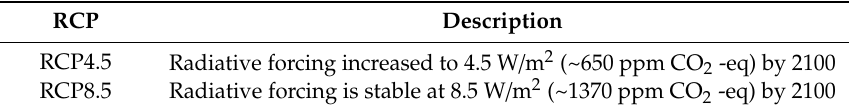
Table 2. Description of Representative Concentration Pathway RCP4.5 and RCP8.5.